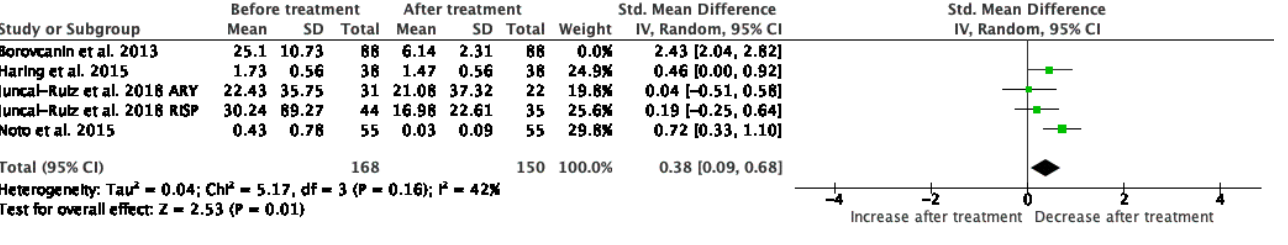
Figure 9. Meta-analysis of IL-4.